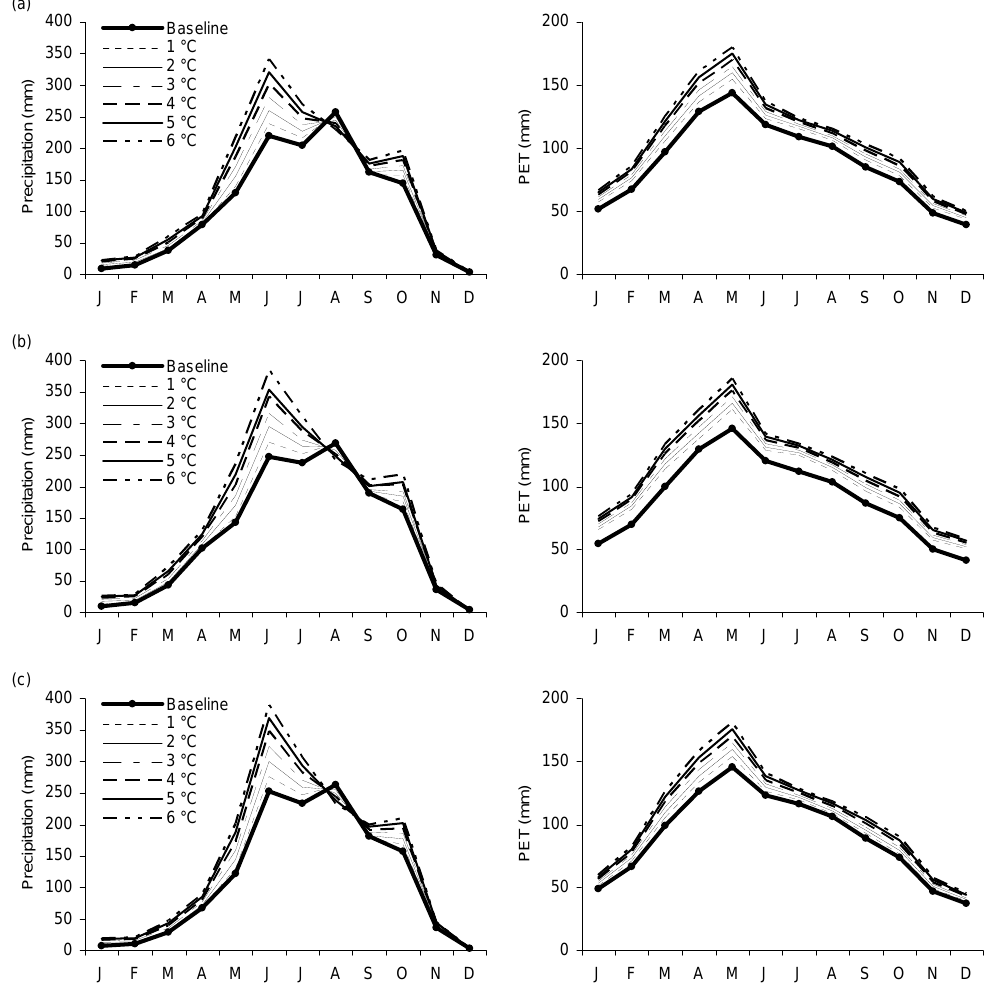
Fig. 5. Precipitation and PET in modelled sub-catchments for the Group 2 scenarios (a) Thoubal, (b) Iril, (c) Nambul (note different y-axis scales for precipitation and